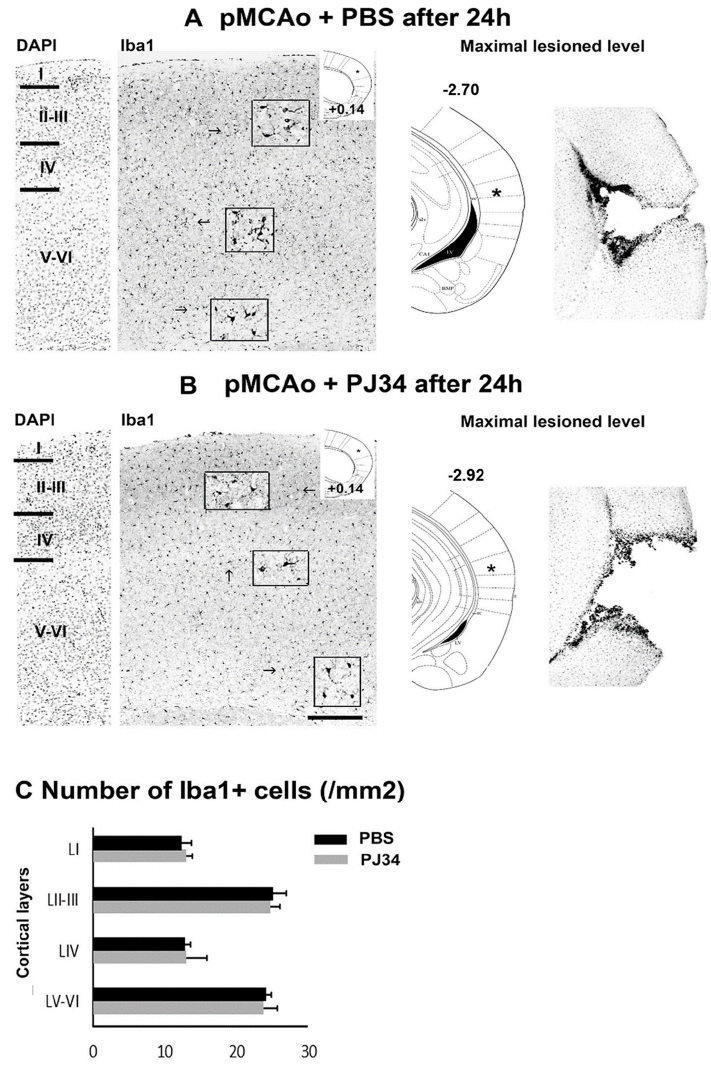
Figure 4. PBS- or PJ34-treated P7 mice show similar numbers of Iba1 expressing microglial cells in the rostral cerebral cortex 24 h after PMCAo. ( A , B ): Example of a PBS- ( A ) and PJ34-treated ( B ) pup showing Iba1+ cells in the different cortical layers. Left caption is taken at bregma level +0.14 mm (asterisk in the caption taken from the atlas). Higher magnifications of Iba1+ cells in various cortical layers are presented in the insets. DAPI labeling of the same section is used to annotate the cortical layers. The right panels are showing Iba1-labeling taken at the level where the lesion appears maximal (asterisk; bregma level − 2.70 ( A ) and − 2.92 ( B ) mm, respectively). Black star indicates the site of the lesion (cavity). ( C ): Quantifications (mean ± SEM) of the densities of Iba1+ cells in the different cortical layers (LI = layer I) in PBS- ( n = 3) and PJ34-treated ( n = 4) pups at +0.14 mm of bregma. A single confocal Z plane (20×) was used for the quantification. Scale bar: Left panels 400 microns; right panels 1300 microns.